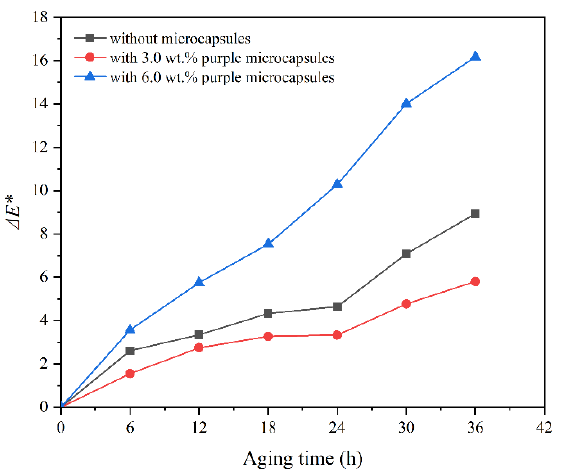
Figure 10. The ∆ E* of the coating on Beli wood with purple shellac microcapsules after aging. Figure 10. The Δ E* of the coating on Beli wood with purple shellac microcapsules after aging. The gloss of the coating is an important index to evaluate its ability to reflect Figure 10. The Δ E* of the coating on Beli wood with purple shellac microcapsules after aging.